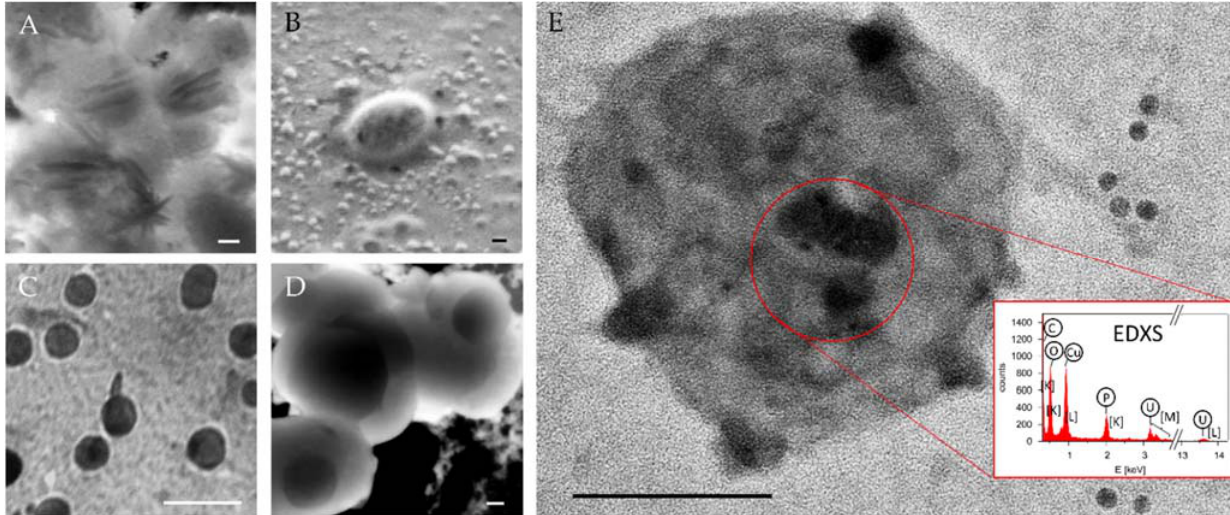
Figure 3. Aspects of electron microscopy in the imaging of EVs isolated by SEC from CSF. ( A ): crystal formation from interaction of phosphate buffer with the contrast solutions (uranyl acetate, OsO 4 ), STEM-BF; ( B ): formation of artefacts in round shape as a result of ‘salt-bubbling’ effect, SE; ( C ): round structures with no membrane bilayer in the size of EVs, TEM-BF at 120 kV; ( D ): round structures with no membrane bilayer in the size of EVs, STEM-BF; ( E ): round structures with darker circles on the surface that could be mistaken for immunogold nanoparticles, but come from the uranyl acetate staining, as evident from the EDXS analysis, TEM-BF. ( A , B , D ): Supra Zeiss 40 (Carl Zeiss AG); ( C ): JEM 1200 EXII (JEOL); ( E ): JEM 2100 (JEOL). Scale bars represent 50 nm length in all images.